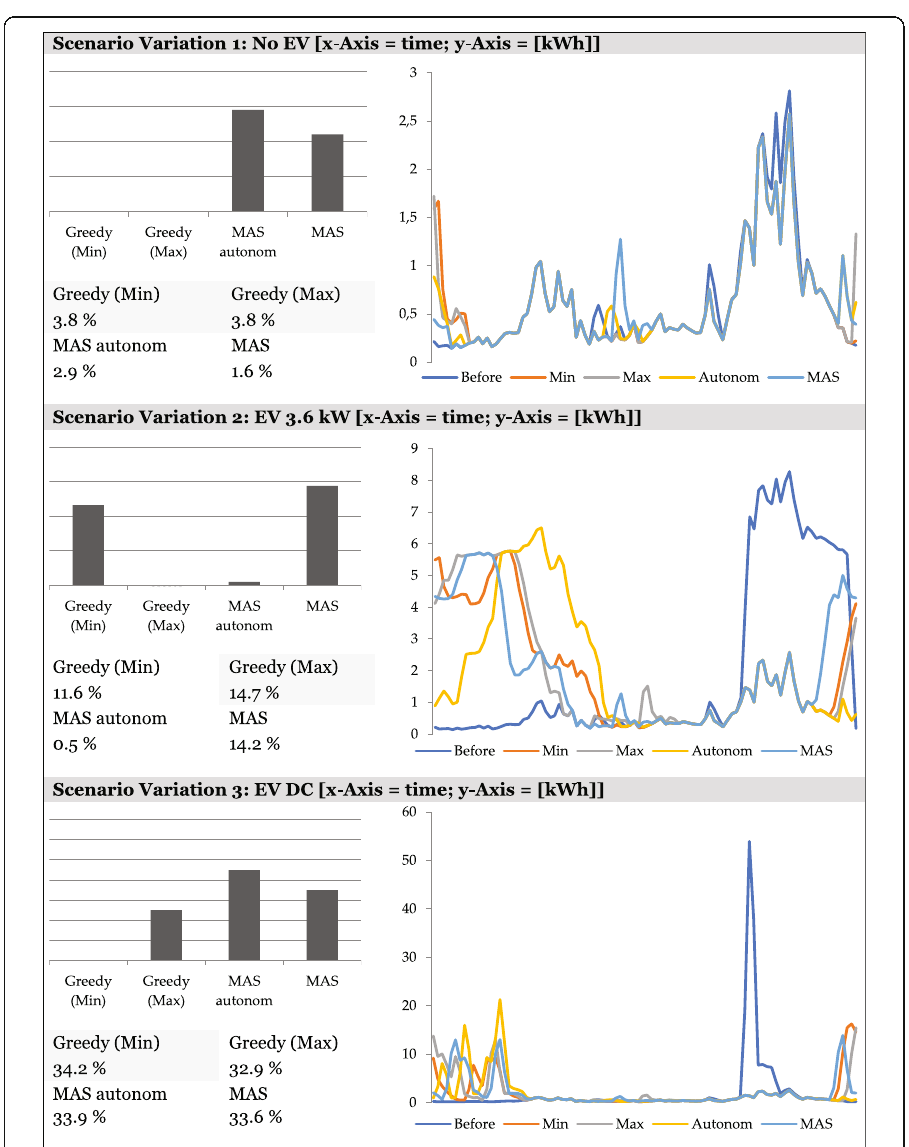
Fig. 6 Results of method benchmarking. Without EV (top), EV charged with 3.6 kW (middle), and EV charged with DC (bottom). The best method for each is highlighted (in light gray). Values = Savings [%] of each method. (For more detailed results see Appendix